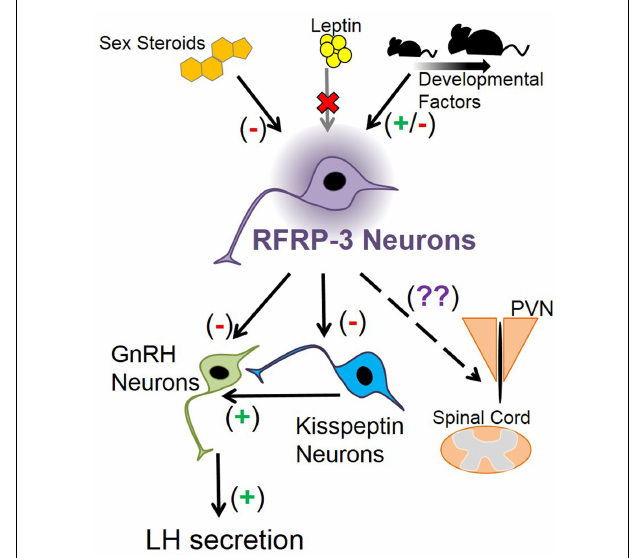
FIGURE 2 | Schematic depicting how Rfrp neurons may fit into mouse neuroanatomy and physiology . Sex steroids are known to inhibit Rfrp expression, primarily through estrogen pathways, while leptin appears to have no major direct effect on Rfrp neurons, at least in development. There appear to be other developmental factors that regulate the development of Rfrp expression which are both stimulatory and inhibitory that remain to be determined. RFRP-3 neurons have efferents that may regulate LH secretion by acting directly on GnRH neurons, or indirectly on GnRH neurons through arcuate kisspeptin neurons or other yet-to-be identified neuronal populations. Other RFRP-3 neuronal target areas include the paraventricular nucleus (PVN) and the spinal cord, and RFRP-3 has unknown effects on these non-reproductive